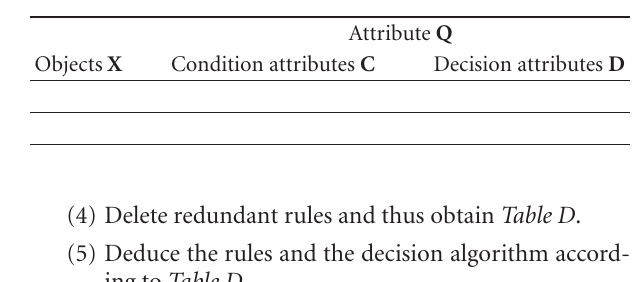
Table 1: Framework of a decision